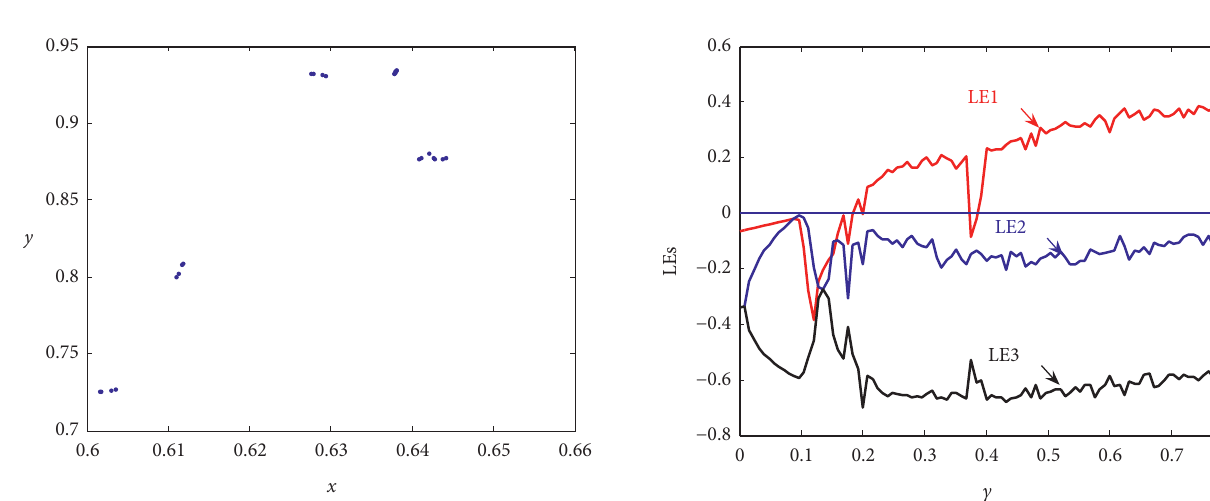
Figure 19: Lyapunov spectrum versus c when a � 1, b � 1.14,